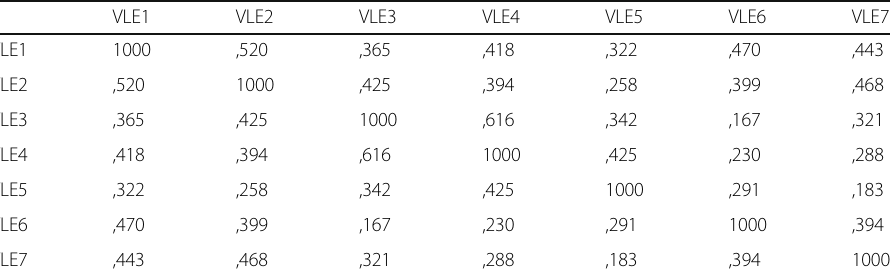
Table 9 Correlations on VLE